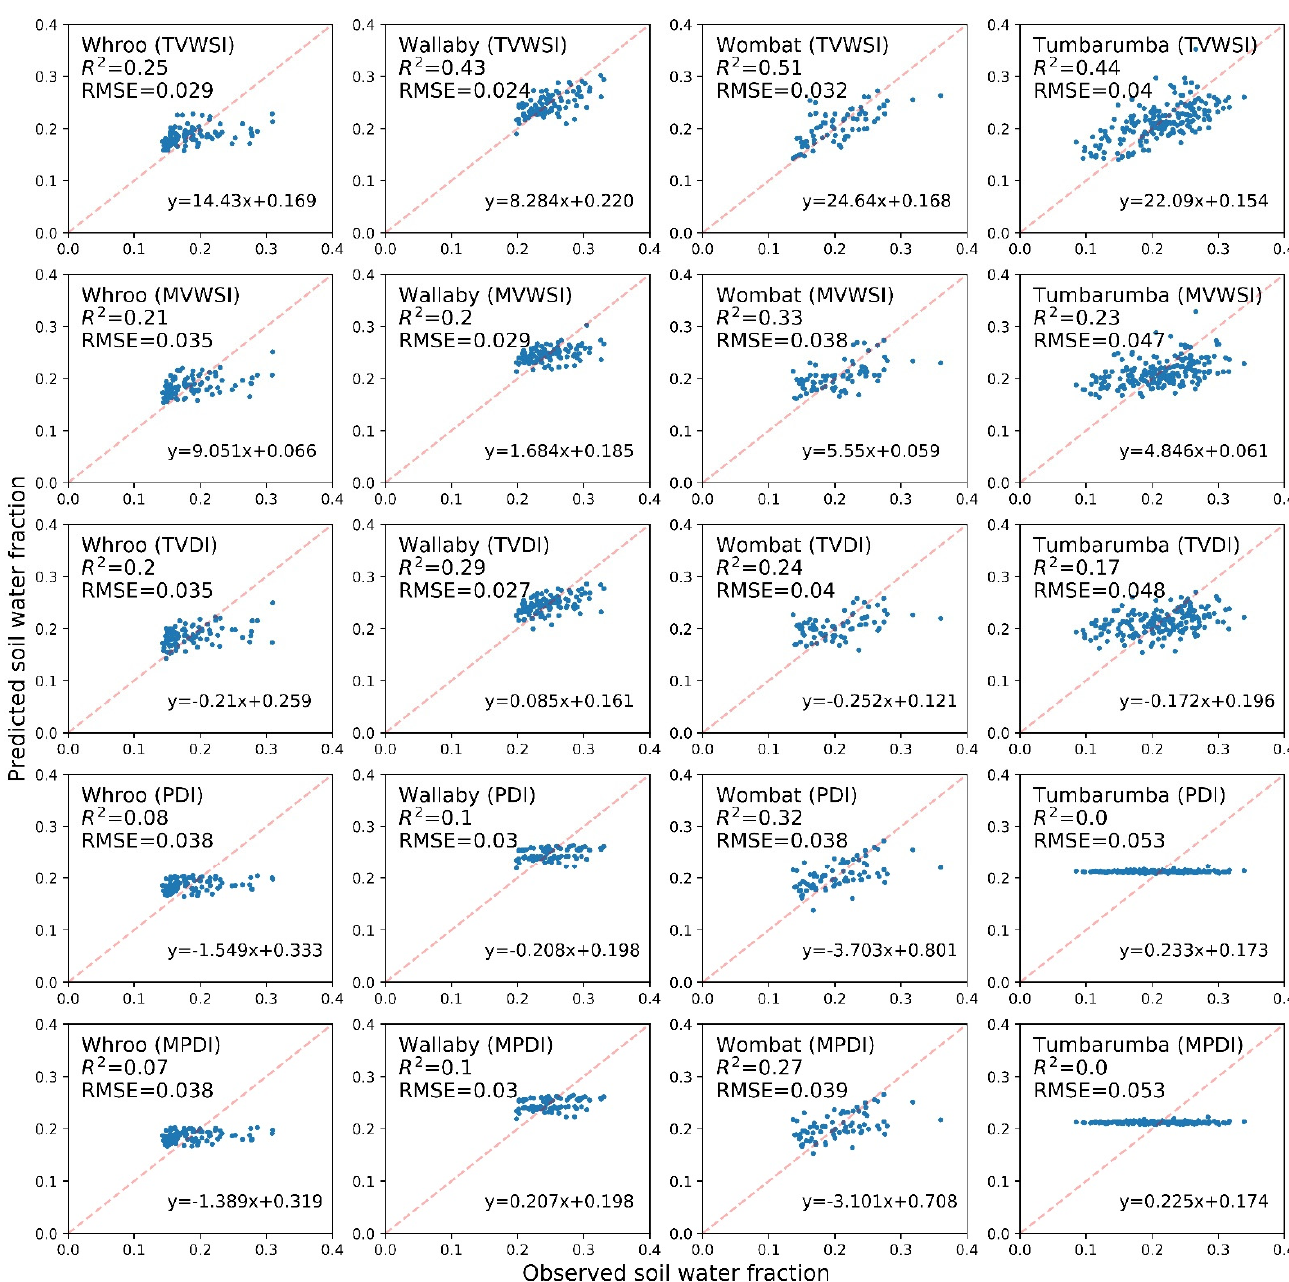
Figure 12. Scatter plots of weekly observed Soil Water Fraction vs. Predicted Soil Water Fraction from four FLUXNET sites (1st column: Whroo; 2nd column: Wallaby; 3rd column: Wombat; 4th column: Tumbarumba) corresponding to the first-order polynomial model fitted to Soil Water Fraction vs. 1st row: TVWSI, 2nd row: MVWSI, 3rd row: TVDI, 4th row: PDI and 5th row: MPDI. The R 2 (observed vs. predicted Soil Water Fraction) and RMSE (observed vs. predicted Soil Water Fraction) are the averages of the 10,000 iterations. The first-order polynomial model equation is shown at each scatter plot.